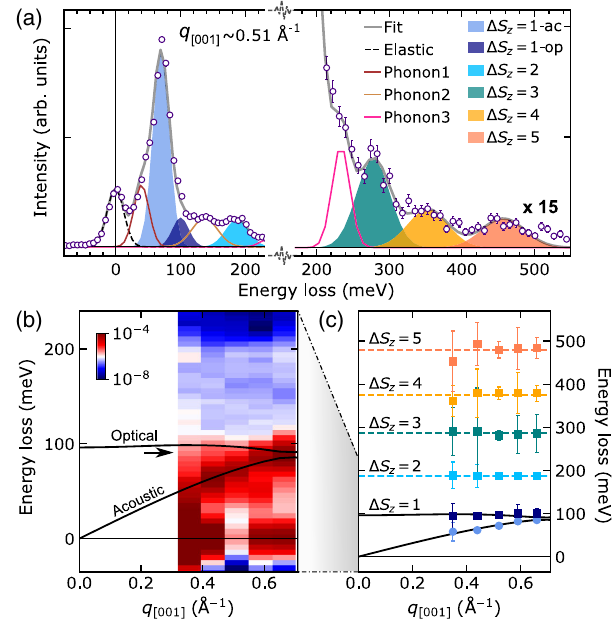
FIG. 2. Momentum dependence of low-energy excitations in 30-nm α -Fe 2 O 3 film. (a) Enlarged view of the selected RIXS spectrum in Fig. 1(c) at q ¼ 0 . 51 Å − 1 (open dots). The low- energy excitations up to 500 meVare fitted with ten Gaussians, as explained in the main text. The gray solid line is the sum of the fitted components. (b) RIXS color map (in logarithmic scale) as a function of q . The spectra are normalized to the integrated spectral weight in the region 0.6 – 8.0 eV. The black lines display the calculated single-magnon acoustic and optical branches for α -Fe 2 O 3 single crystal [38]. (c) Fitting results in terms of peak position versus q for the six unconstrained solid-filled Gaussians. The black lines are the same as in (b) and the color code is the same as in (a). The fit error bar is defined in Sec. V of the Supplemental Material